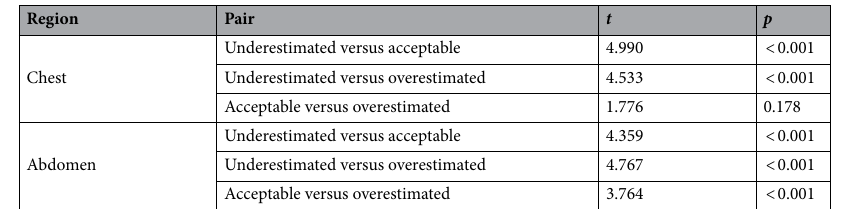
Table 3. Pairwise comparisons of actual body weights between underestimated, acceptable, and overestimated cases. The underestimated group was defined as the subjects with > − 5 kg from their actual body weight. The acceptable group was defined as the subjects within ± 5 kg from their actual body weight. The overestimated group was defined as the subjects with > 5 kg from their actual body weight. The p -values were calculated by performing the Steel–Dwass